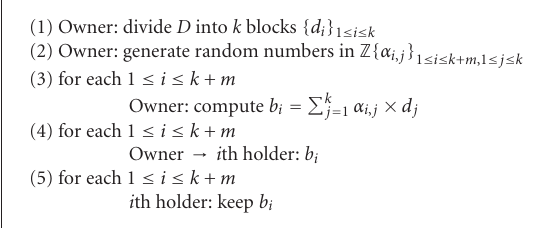
Figure 4: Verification